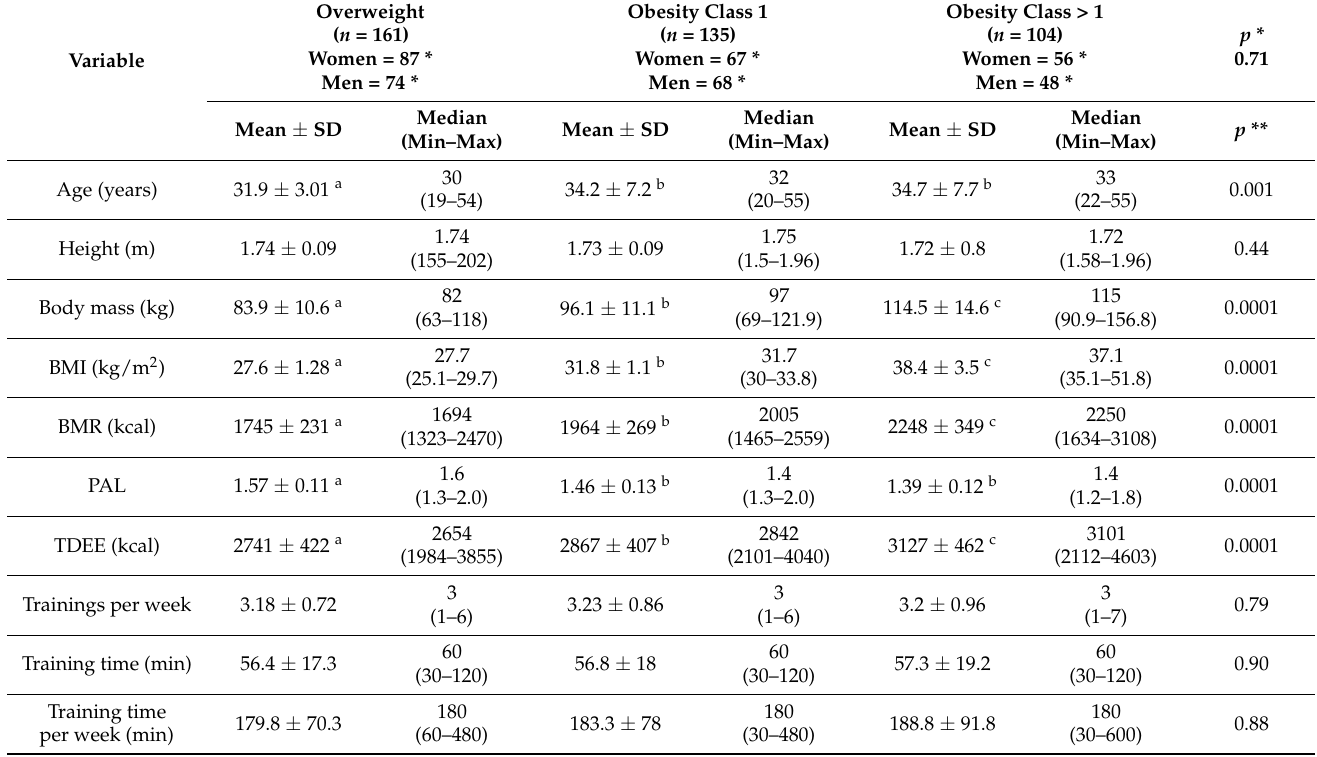
Table 3. Characteristics of all individuals observed at the beginning of the intervention by BMI